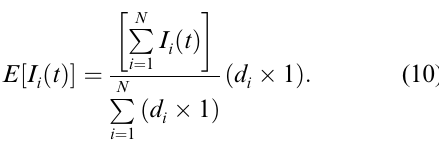
Transshipment strategy